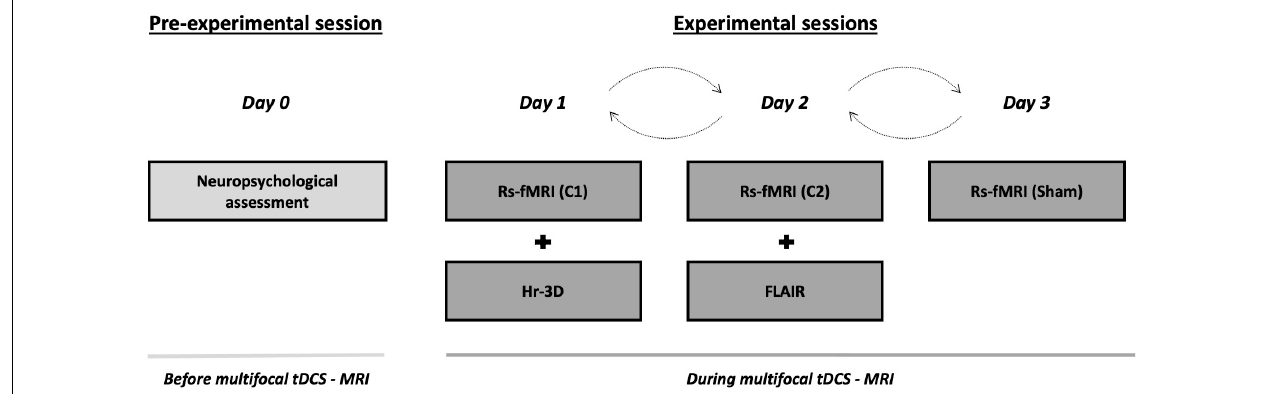
FIGURE 1 | Study protocol and timeline of the procedures accomplished before and during multifocal tDCS-MRI. On the pre-experimental session, all the subjects undertook a neuropsychological screening session to verify a normal cognitive functioning. Then, during the three consecutive experimental sessions, transcranial stimulation was delivered using differential tDCS montages (i.e., C1, C2 and sham) in a counterbalanced fashion while rs-fMRI data was acquired. A hr-3D and a FLAIR datasets were acquired for additional examinations. tDCS, transcranial direct current stimulation; MRI, magnetic resonance imaging; rs-fMRI, resting-state functional MRI; hr-3D, high-resolution three-dimensional; FLAIR, fluid-attenuated inversion recovery; C1, condition 1; C2, condition